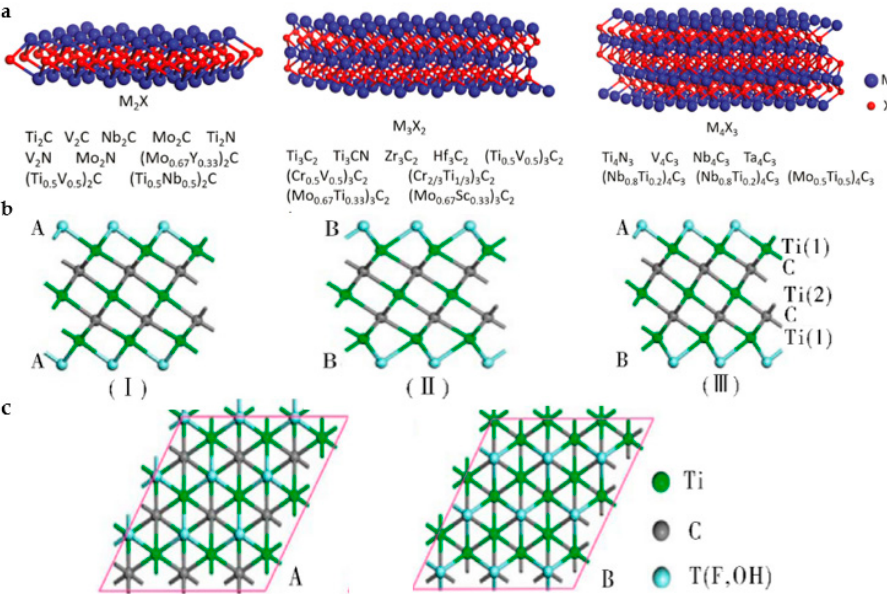
Figure 7. ( a ) X elements are interspersed between the second, third, and fourth layers of the M elements of M 2 X, M 3 X 2 , and M 4 X 3 , respectively. (Reprinted from ref. [80]). ( b ) Side view and ( c ) top view of Ti 3 C 2 T 2 structure. (Reprinted with permission from ref. [83]. Copyright 2012 American Chemical Society Publications).